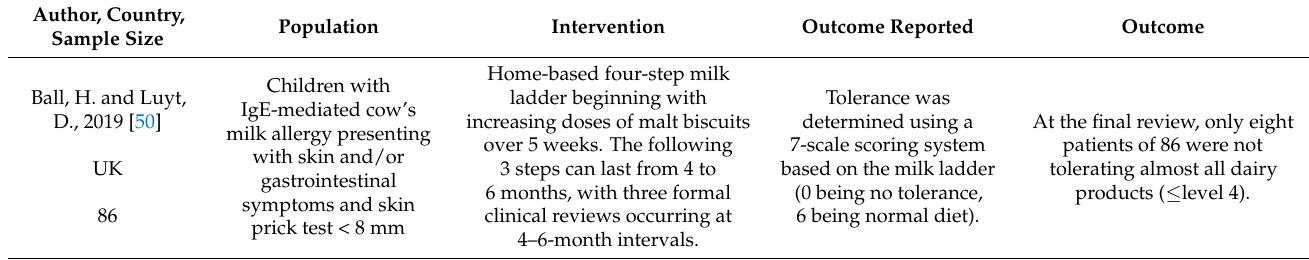
Table 3. Studies exploring the use of baked milk introduction and the milk